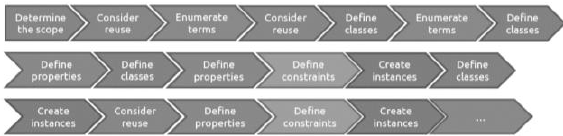
Figure 1. Ontology101 Guide (Standford University, Noy and McGuinness,